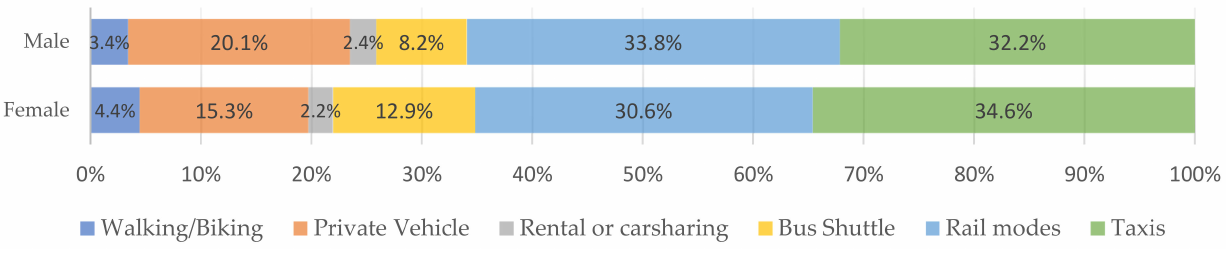
Figure 5. Replaced mobility mode by ridesourcing among female and male